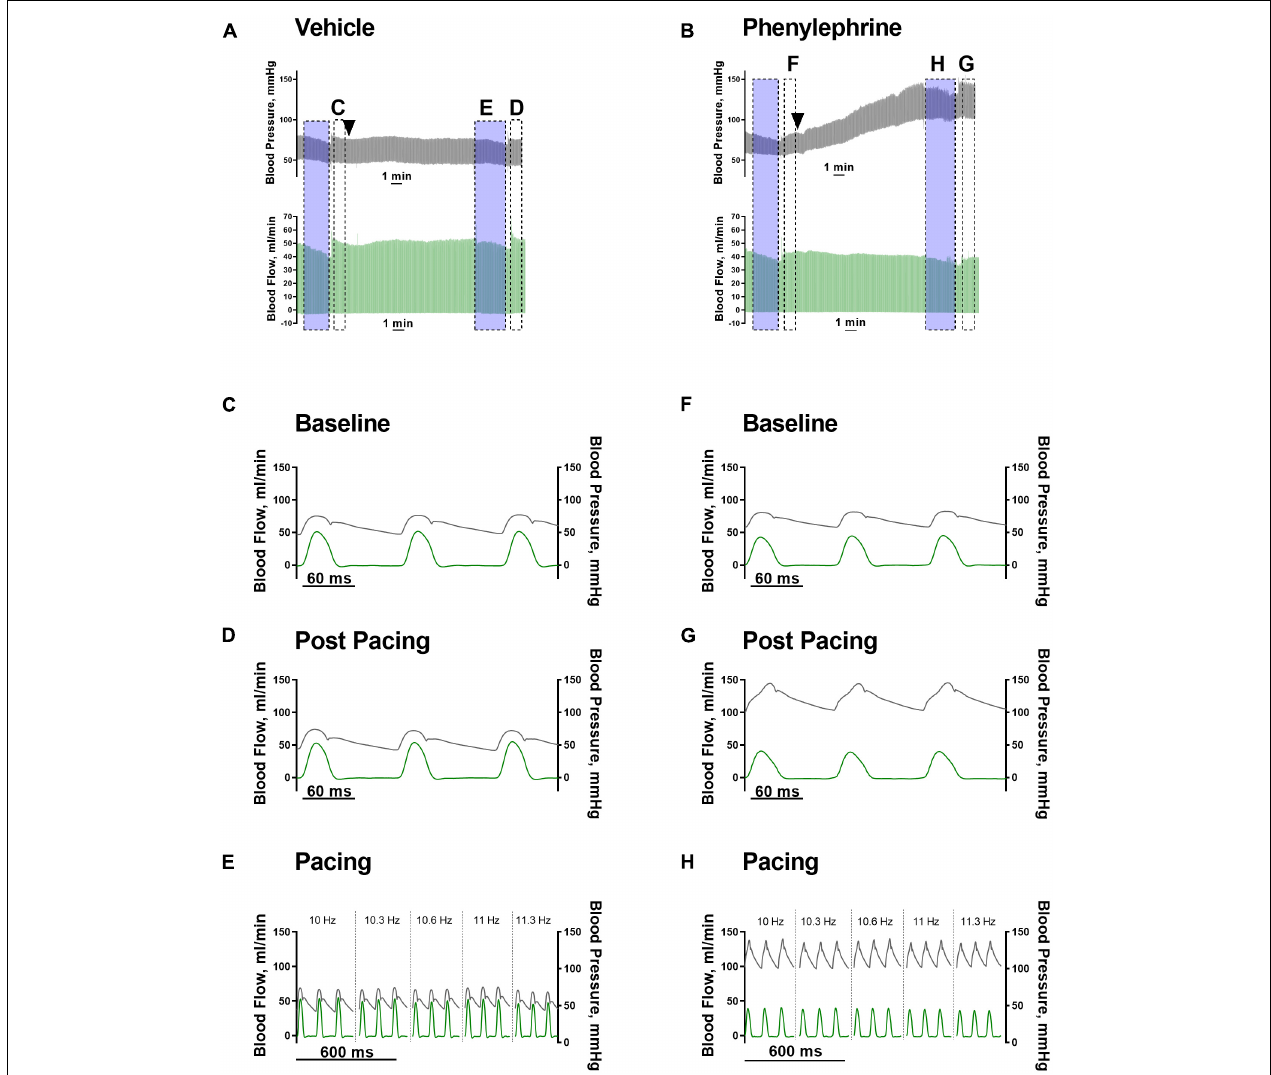
FIGURE 3 | (A,B) Representative traces of blood pressure (black traces) and blood flow (green traces) after vehicle or phenylephrine administration (black arrow heads). Transparent blue boxes indicate periods of pacing. Panels (C–H) are indicated in panels (A,B) . (C,F) Hemodynamic parameters prior to vehicle or phenylephrine administration. (D,G) Hemodynamic parameters after vehicle or phenylephrine administration and post second atrial pacing. (E,H) Hemodynamic parameters during second atrial pacing and after vehicle or phenylephrine